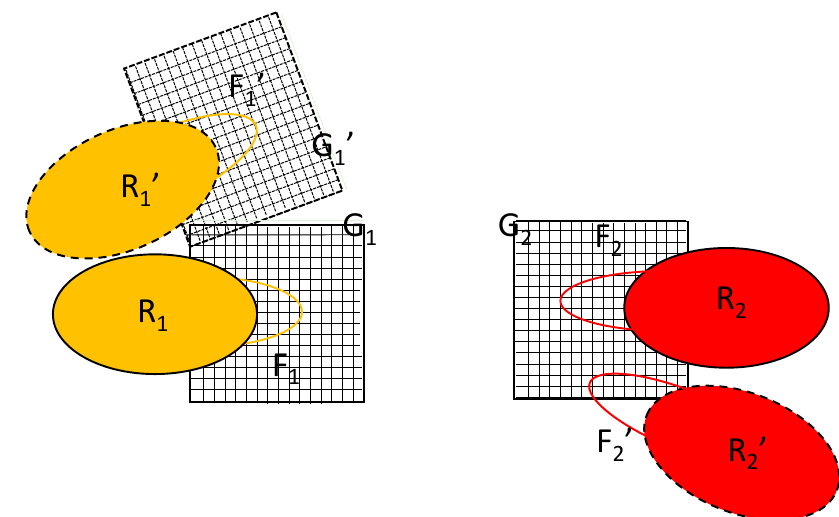
Figure 2. Schematics of the copies needed for the proposed algorithm. R 1 , R 2 : rigid part of macromolecules 1 and 2, respectively; F 1 , F 2 : flexible part of macromolecules 1 and 2, respectively; G 1 , G 2 : The set of grids representing the field of the rigid parts R 1 and R 2 , respectively; Primed items represent the systems after change from the initial position, orientation and conformation. The two interacting systems are shown with their distance increased for clarity.